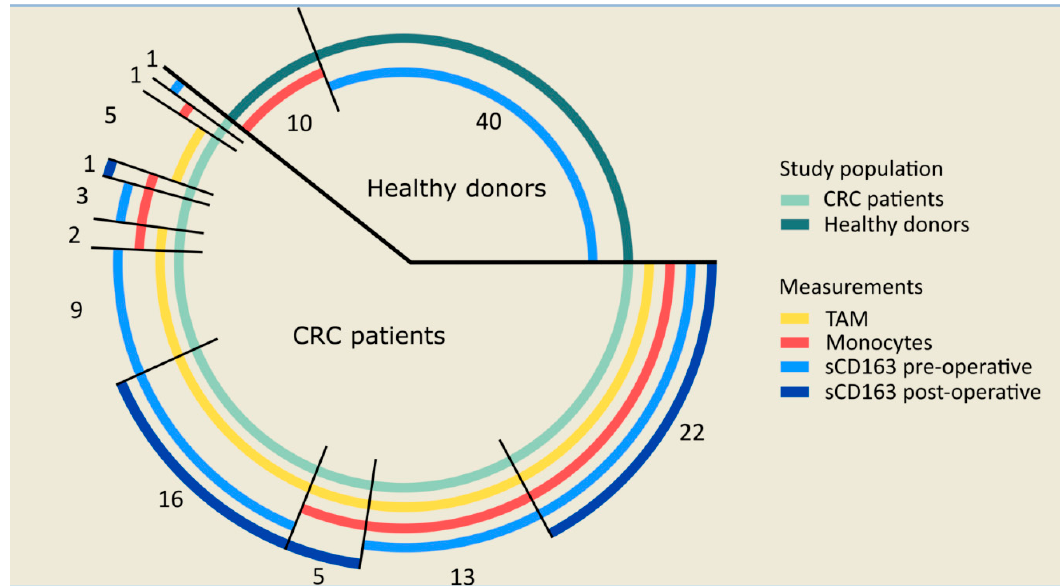
Figure 1. Sample availability for the measurement of monocytes, sCD163 and tumor-associated macrophages (TAMs) in colorectal cancer (CRC) patients and healthy donors. Monocytes, sCD163 and TAMs were studied in 78 CRC patients. TAMs and monocytes were studied in 72 and 47 CRC patients, respectively. Additionally, sCD163 levels were studied in 64 pre-operative and 44 post-operative patients. Finally, monocytes were studied in 10 healthy donors, whereas sCD163 levels were studied in 40 healthy donors. The numbers in the figure indicate the number of patients in each subgroup with overlapping samples. Abbreviations: CRC (colorectal cancer), ELISA (enzyme-linked immunosorbent assay), PBMC (peripheral blood mononuclear cells), sCD163 (soluble CD163), TAM (tumor-associated macrophages). Table 1. Clinicopathological characteristics of patients with CRC and healthy donors in the study. Statistically significant p -values ( ≤ 0.05) are indicated in bold. Abbreviations: CRC (colorectal cancer),